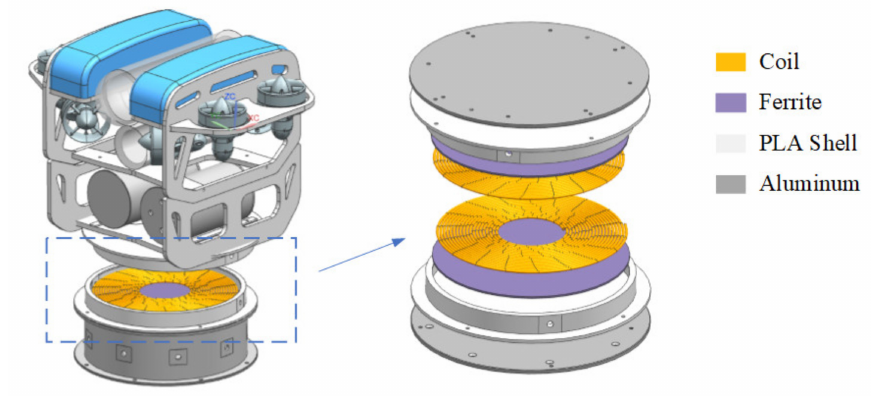
Figure 2. Coupler structure of the WPT